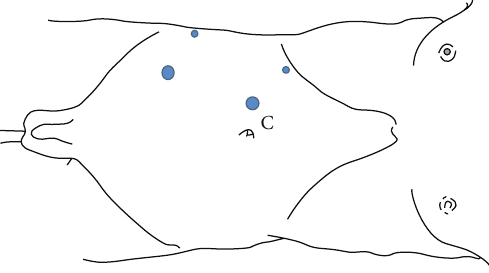
Figure 3: Line diagram of ports position.